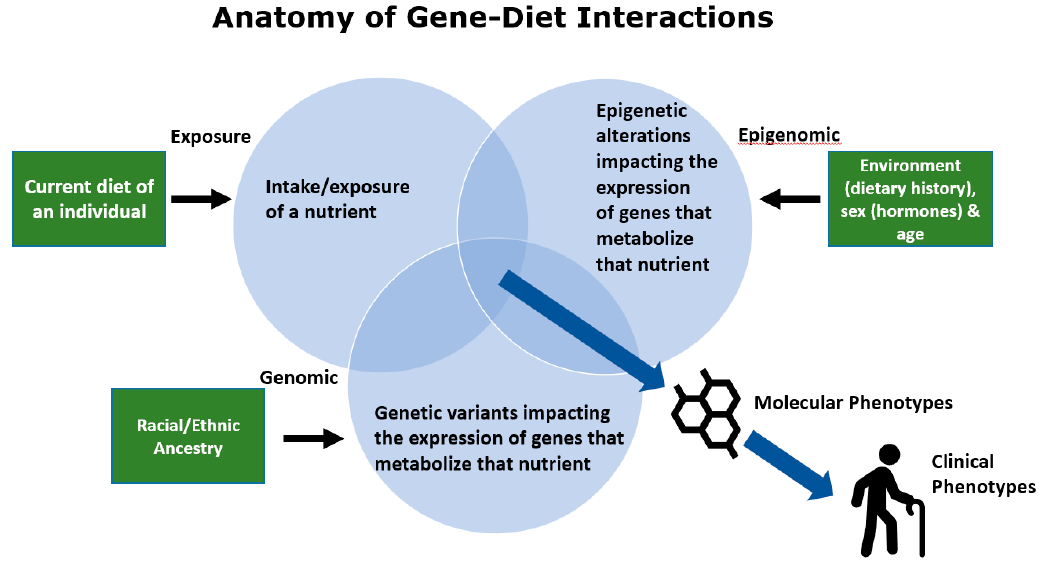
Figure 2. Anatomy of gene–diet interactions giving rise to molecular and clinical phenotypes.